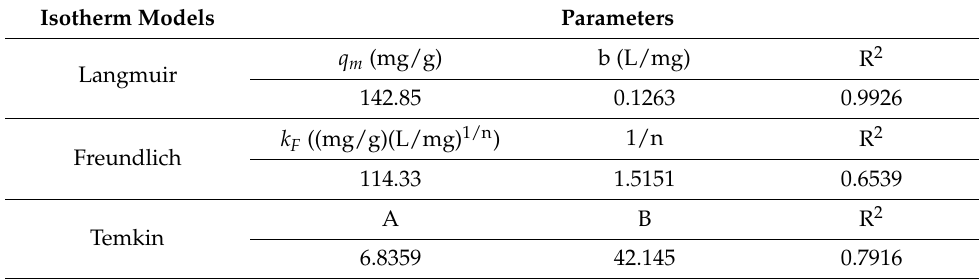
Table 2. Isotherm modeling parameters for BG adsorption on GO-PANI.